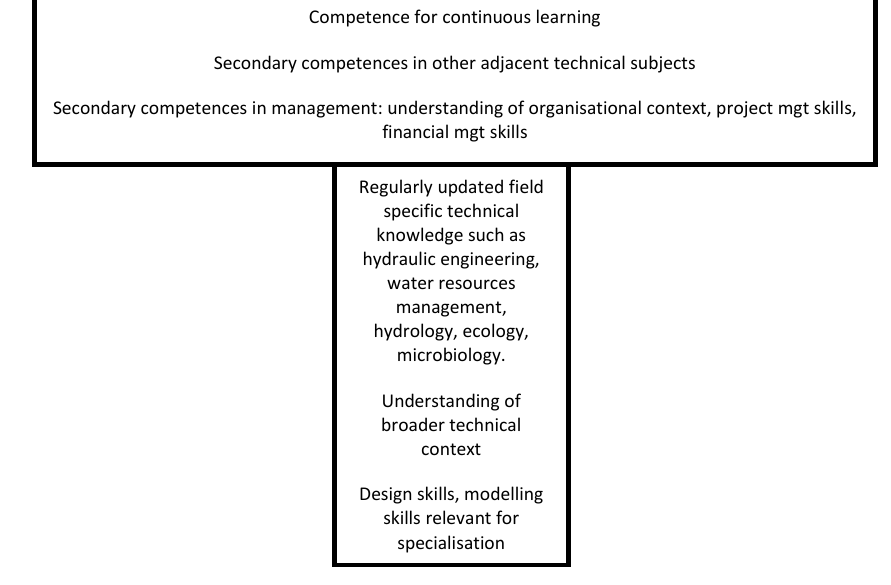
Fig. 1. Hypothetical T-shaped competence profile for a technical water